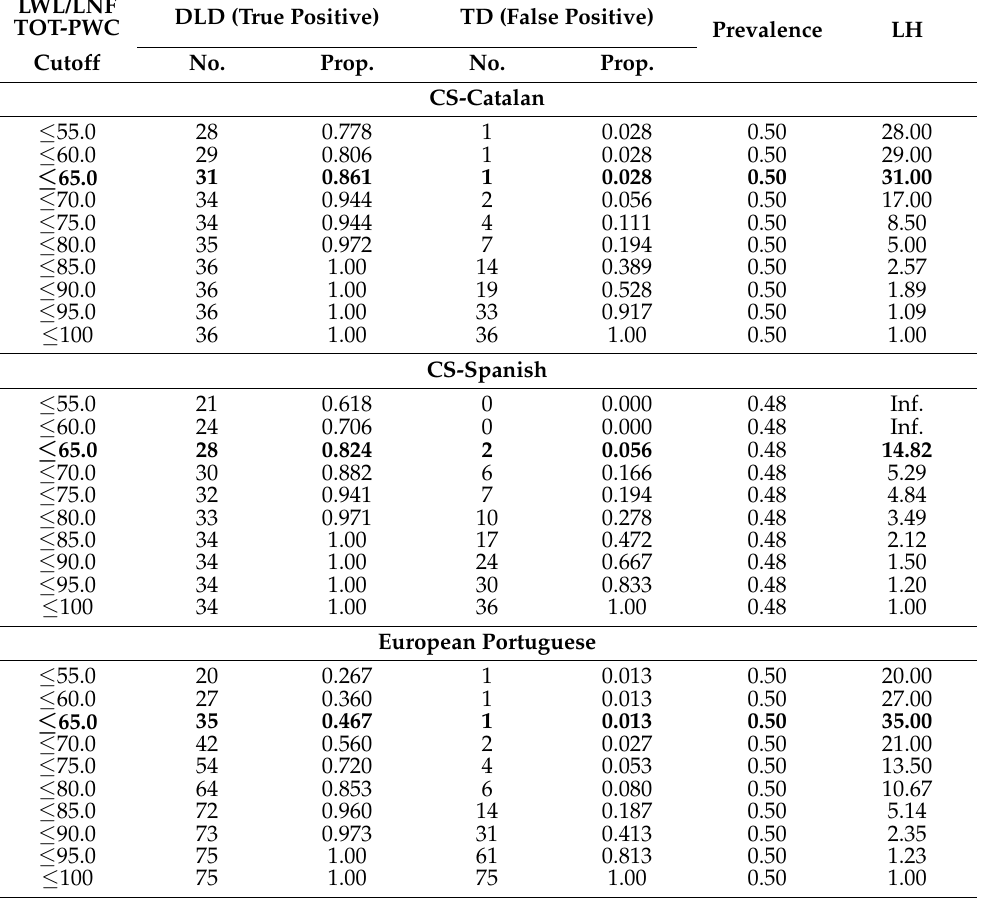
Table 13. The number and proportion of children with a positive test result (ruling in disorder), prevalence and likelihood ratio (LH) for each of the cutoff value based on total word percentage correct (TOT-PWC) for LOW wordlikeness (LWL) nonwords for Catalan and Portuguese NRT (NRT- Cat and NRT-Port) and LOW nonword frequency (HNF) nonwords for Spanish NRT (NRT-Spa) for the Catalan–Spanish (CS) and European Portuguese (EP) children with developmental language disorder (DLD) and typically developing (TD) controls. LWL/LNF DLD (True Positive) TD (False Positive) TOT-PWC Prevalence LH Cutoff No. Prop. No.